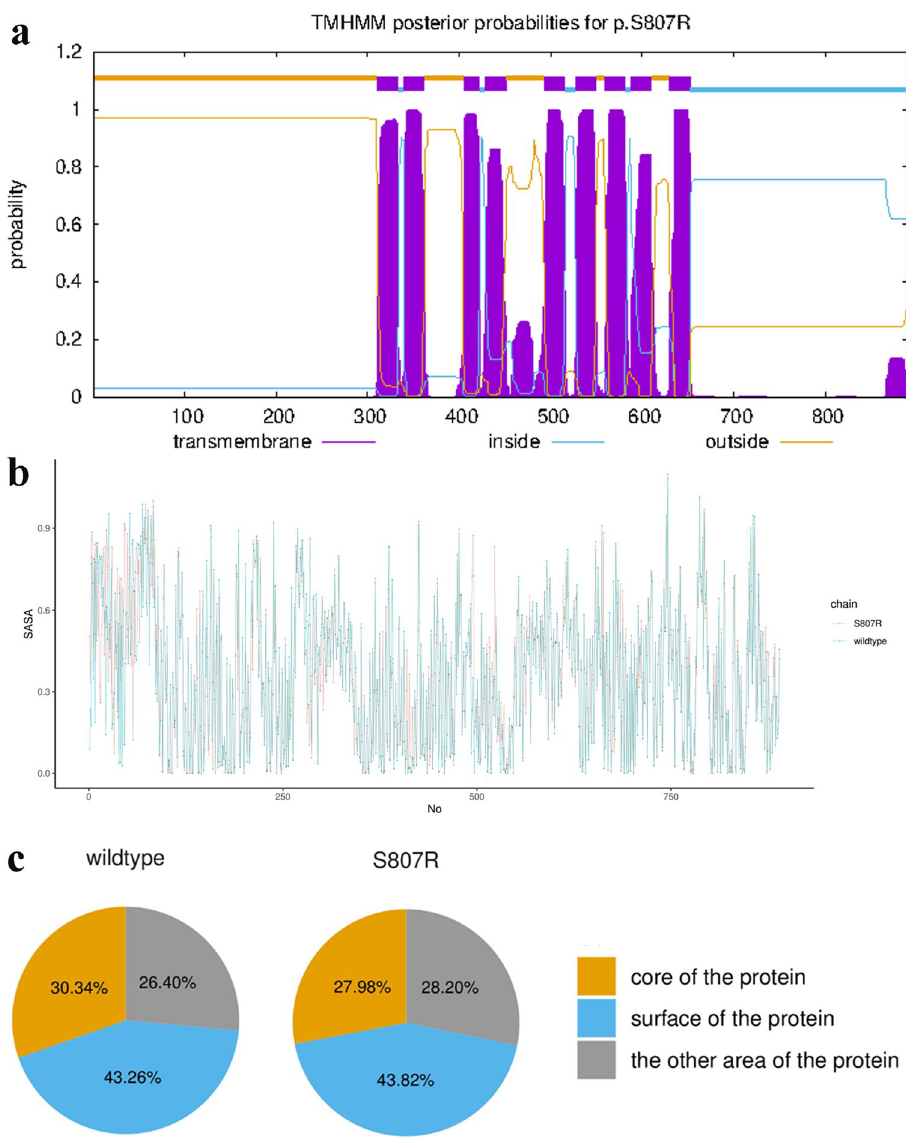
Figure 3. Combined figure. ( a ) The nine transmembrane regions in mutant S807R protein are shown by TMHMM server. ( b ) The bottom panels describe per-residue SASA of wolframin protein and mutant S807R protein. ( c ) The distribution about the SASA of all 890 amino acids in wild and mutant S807R